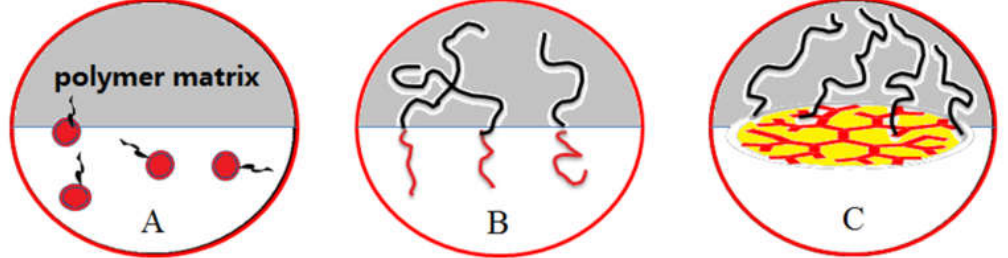
Figure 5. Schematic of small surfactant ( A ), block copolymer ( B ), and ( C ) PEI macrosurfactant-mediated unit of an emulsion.